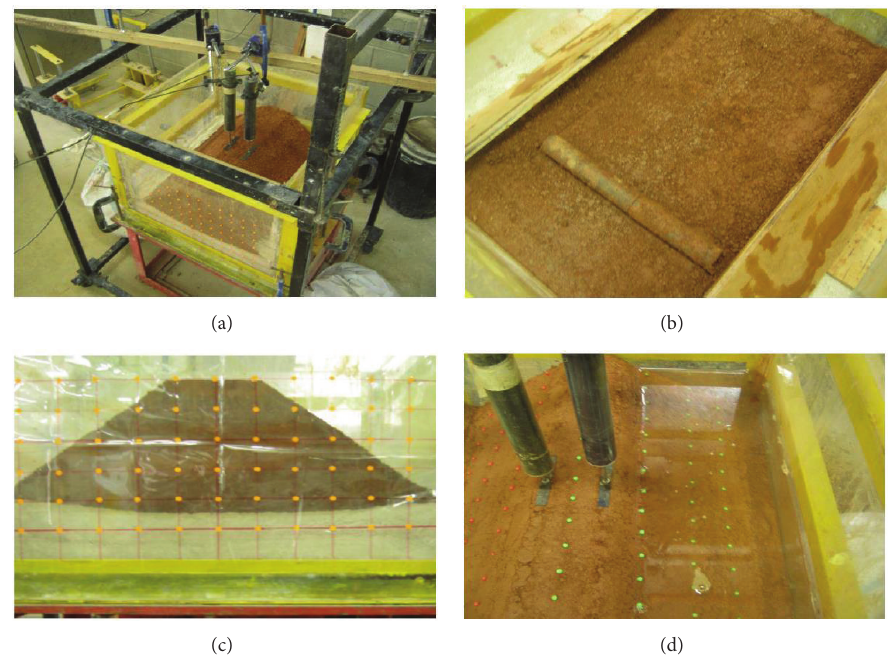
Figure 18: Small scale dam. (a) Dam perspective with two LVDT, (b) soil compaction with roller, (c) dam section with index network, and (d) dam with tank before